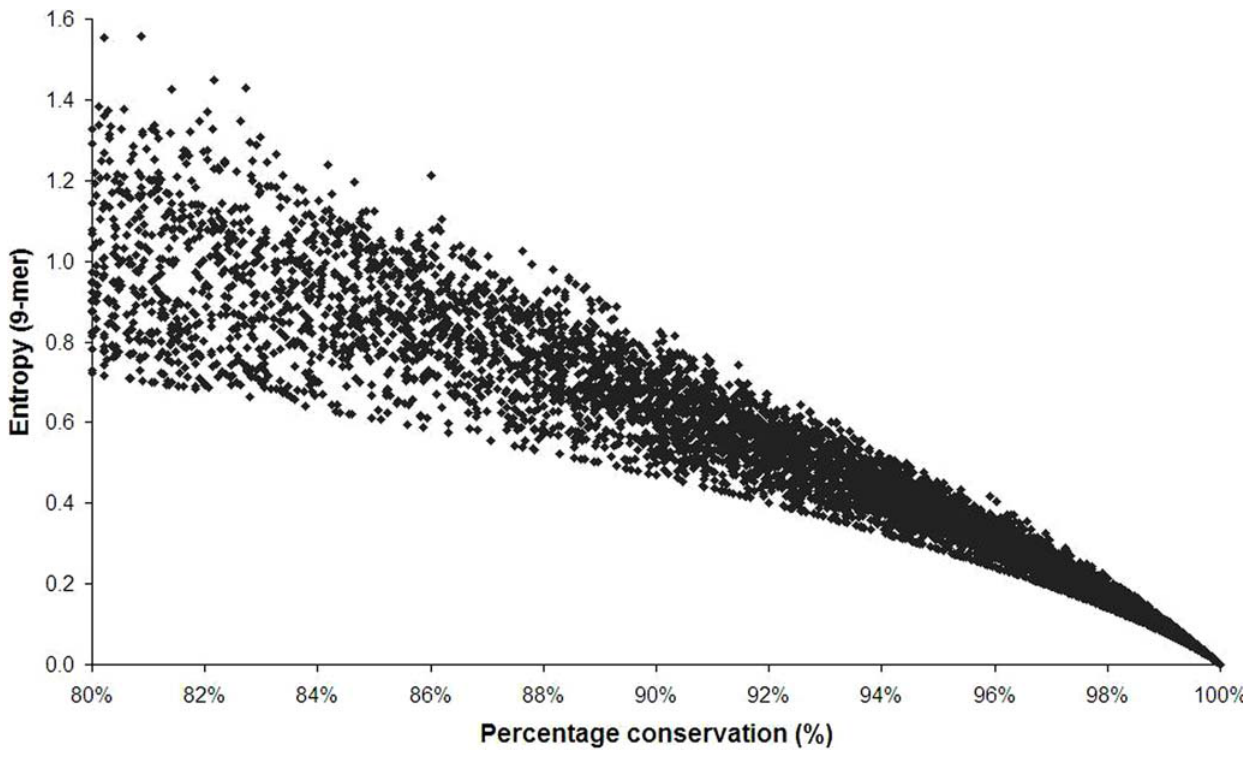
Figure 5. Entropy-sequence conservation relationship, plotted from data in this study (see Figure 2–4). The boxed region indicates area whereby conservation of $ 90% correlates to entropy of 0.8 or less. doi:10.1371/journal.pone.0001190.g005 Table 3. The influenza A virus proteins, their length, the number of conserved sequences, and the combined length